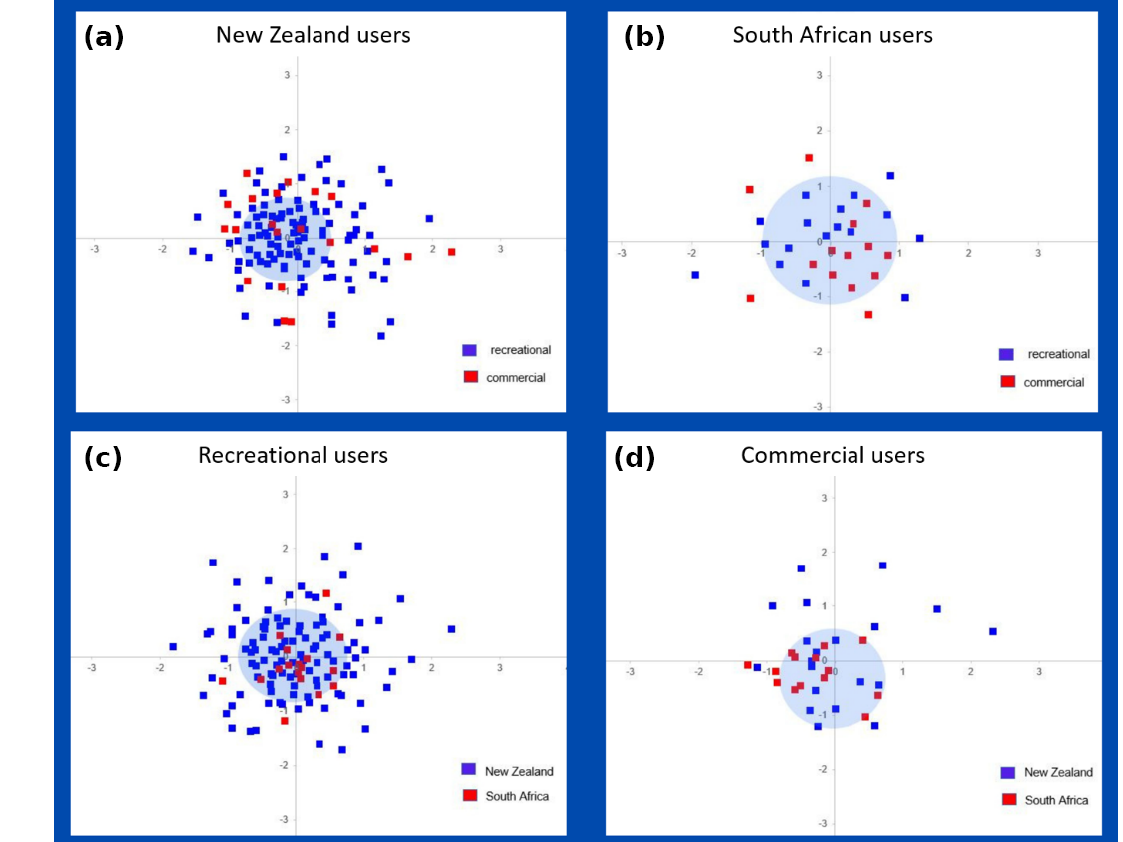
Figure 5. Nonmetric, multidimensional scaling of agreement in the subgroups. Blue oval at centre is an approximate grouping of respon- dents whose individual competence score was 0.6 or greater. (a) New Zealand ocean users (stress = 0.263); (b) South African ocean users (stress = 0.237); (c) recreational ocean users (stress = 0.258); (d) commercial ocean users (stress =